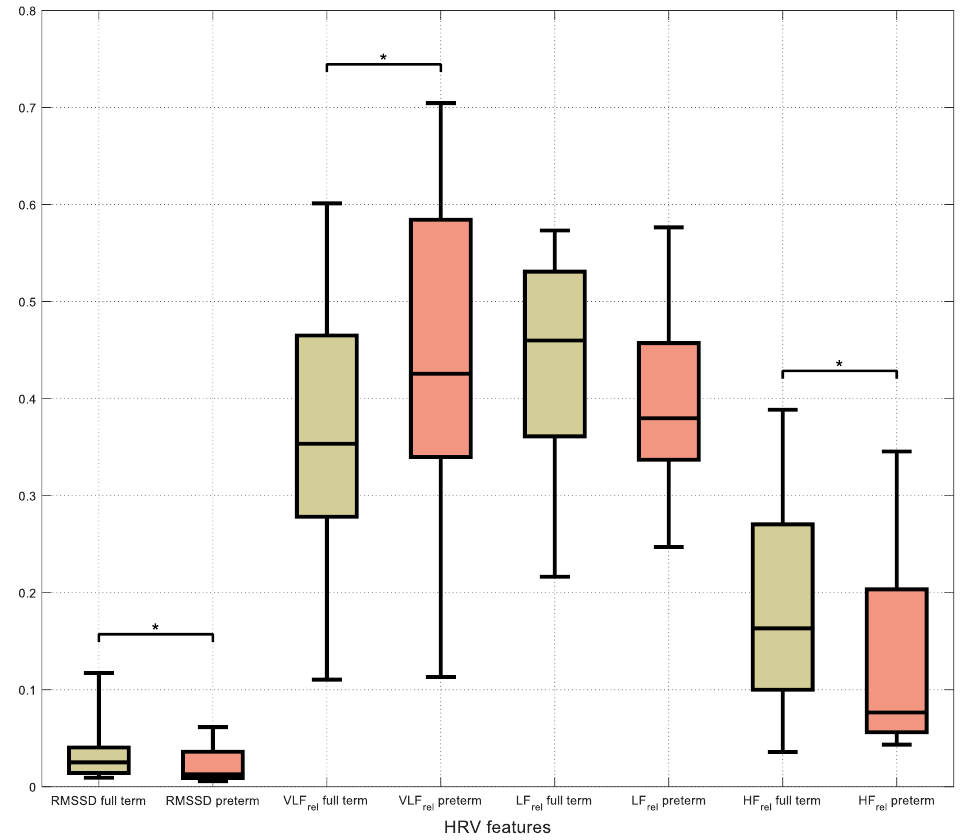
Figure 1. Box-plots of the HRV parameters RMSSD, VLF, LF, HF for the whole recording duration. Asterisk denotes statistically significant difference at 0.05 level.